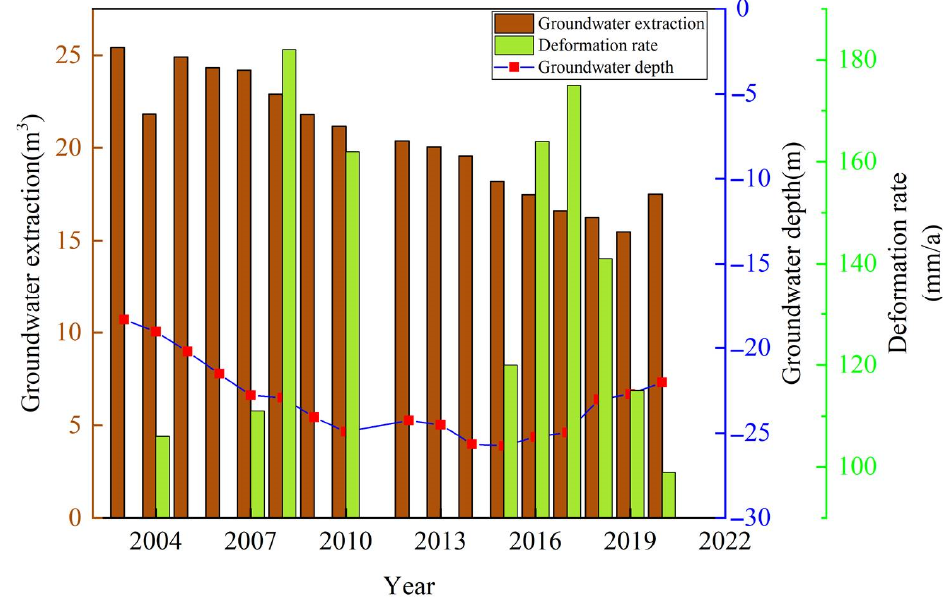
Figure 13. Evolutionary trend of groundwater data and deformation results from 2003 to 2020.